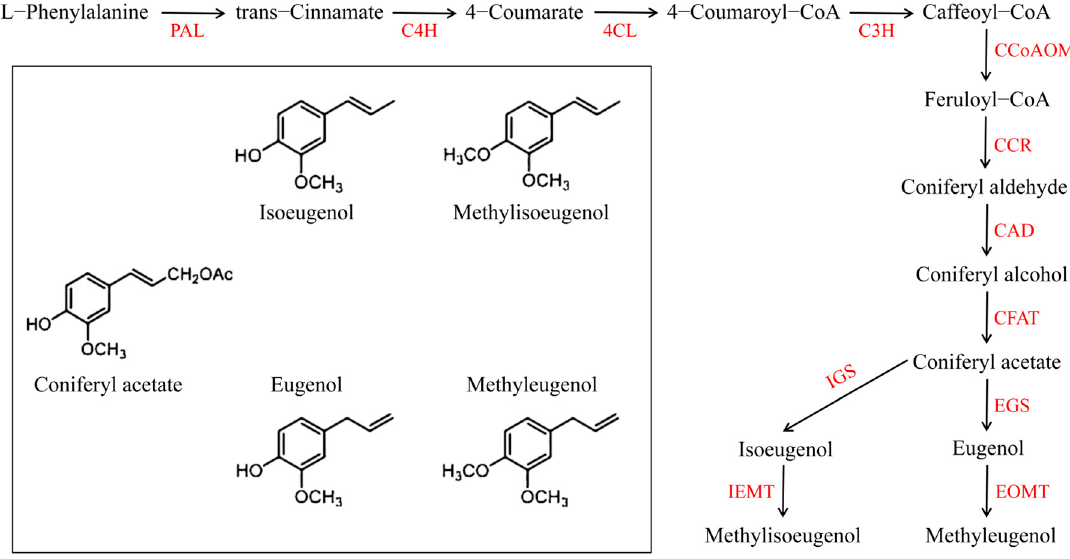
Figure 1. The biosynthesis pathways of methyleugenol